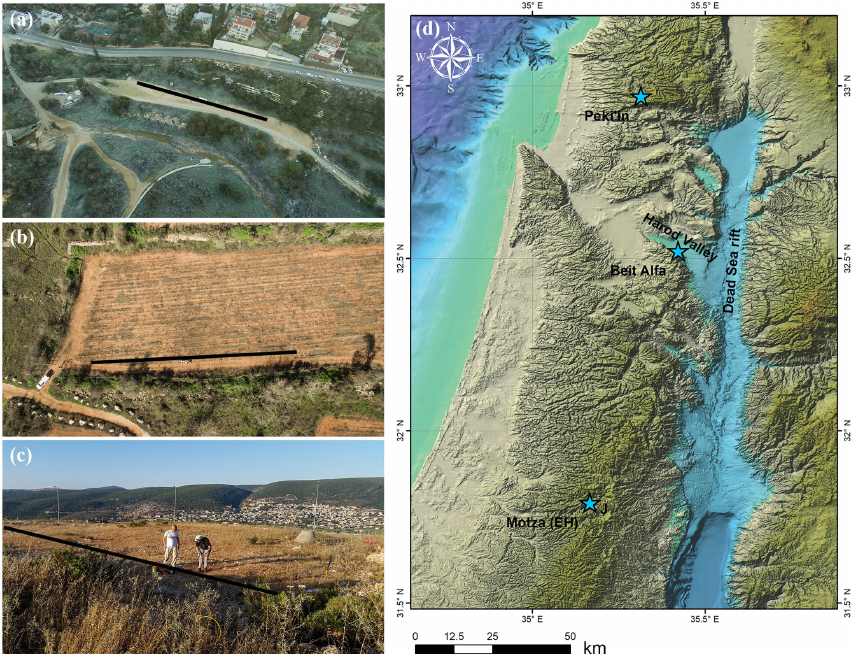
Figure 11. Three of the sites investigated: (a) Motza 1, (b) Motza 2 and (c) Peki’in. Black lines represent the seismic line location. (d) The locations of the sites over a 25m DTM image (Hall, 2008). Also shown are sites mentioned in the text: Jerusalem (J) and Emek HaArazim (EH).